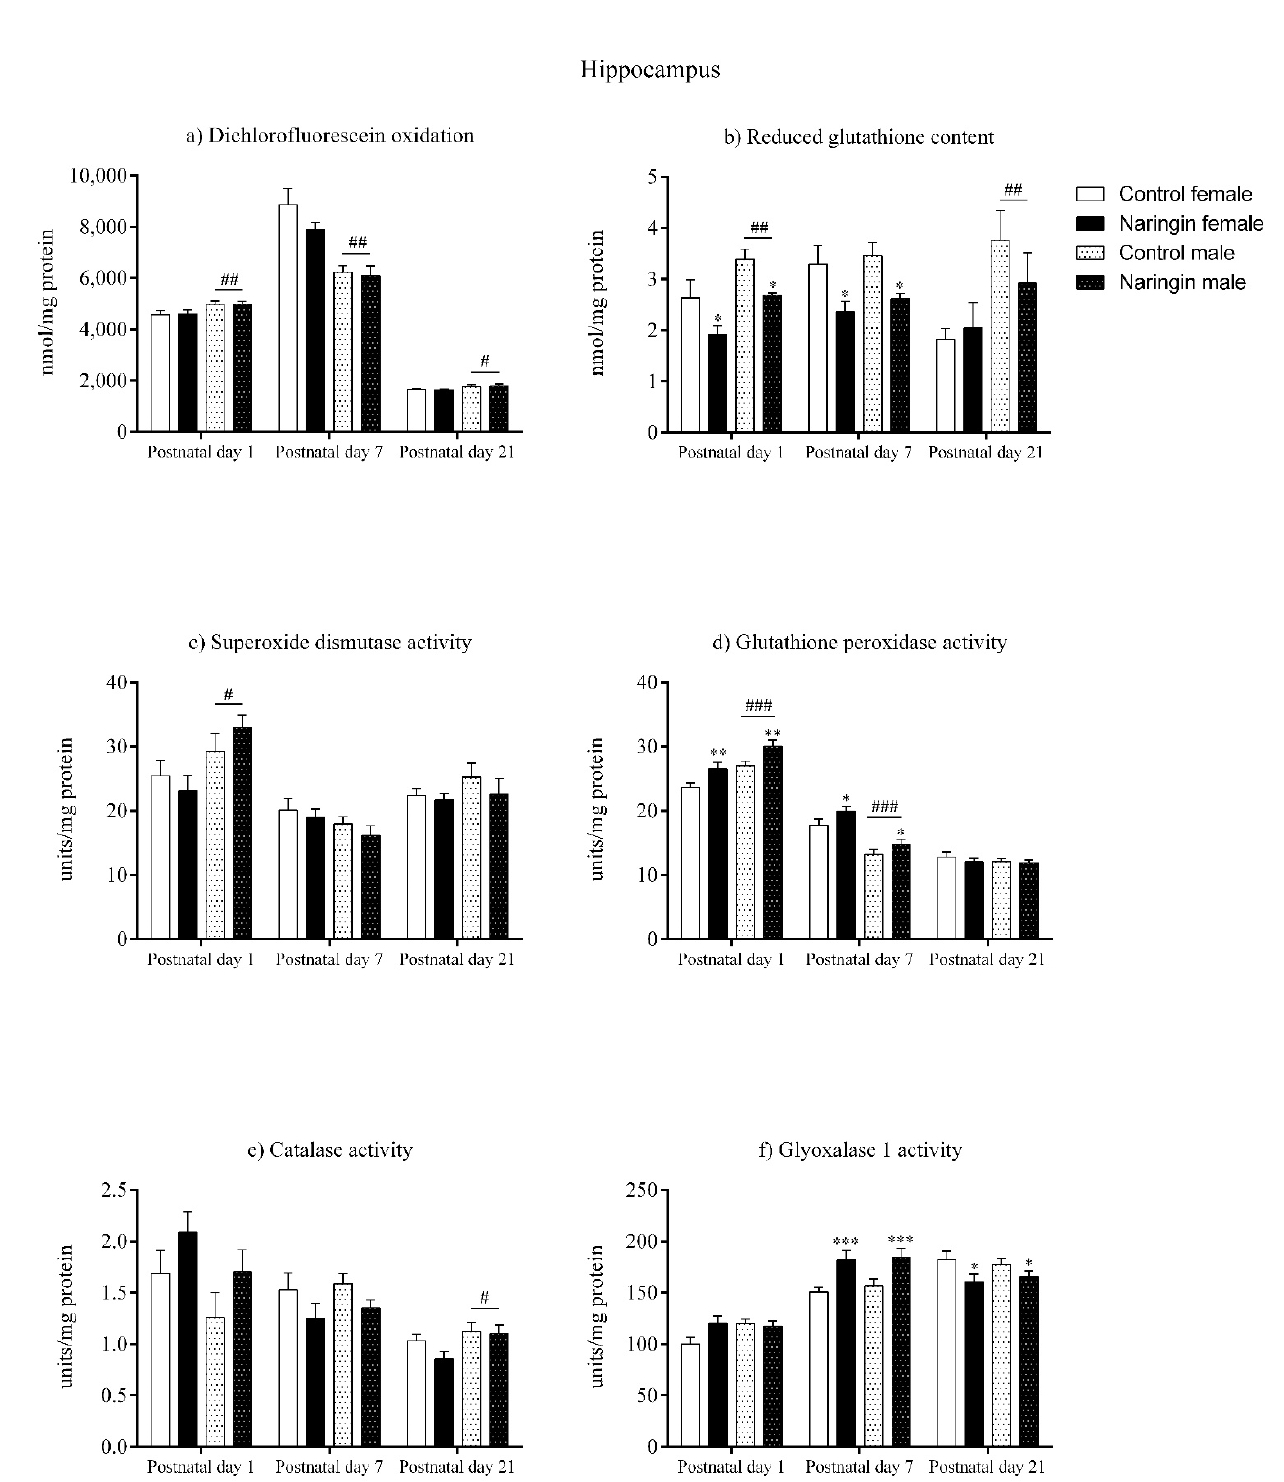
Figure 2. Effects of maternal naringin supplementation during the third week of gestation on the ( a ) dichlorofluorescein oxidation, ( b ) reduced glutathione content, ( c ) superoxide dismutase activity, ( d ) glutathione-peroxidase activity, ( e ) catalase activity, and ( f ) glyoxalase 1 activity in the offspring’s hippocampus on postnatal days 1, 7, and 21. Results are expressed as mean ± S.E.M. Control female n = 8, naringin female n = 8, control male n = 8, naringin male n = 6. * p < 0.05; ** p < 0.01; *** p < 0.001; # p < 0.05; ## p < 0.01; ### p < 0.001 (two-way ANOVA). Asterisks represent a main supplementation effect, and the hashes on bars represent a main sex effect. The asterisks on bars (single bracket) represent the significant comparisons by Sidak’s post-hoc test when interactions occurred.